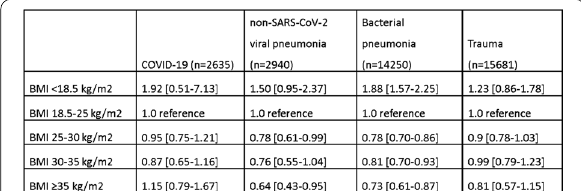
Table 1 Odds ratios of in-hospital mortality of BMI categories in the multivariate logistic regression model, with BMI 18.5–25 kg/m2 used as Reference category. Covariates used for this analyses included sex, age, medical history (chronic diagnoses), APACHE III acute physiology score (APS), vasoactive medication and mechanical ventilation and PaO2/FiO2 ratio on ICU admission